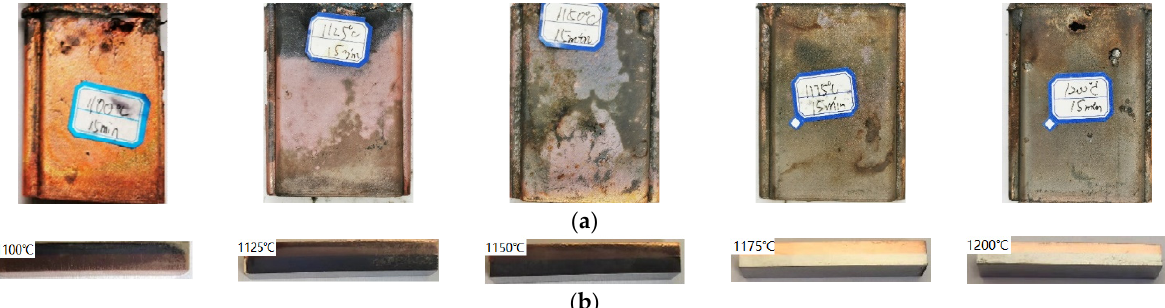
Figure 2. Profiles of casting compound samples at different casting temperatures. ( a ) surfaces of the samples; ( b ) cross ‐ section of samples.